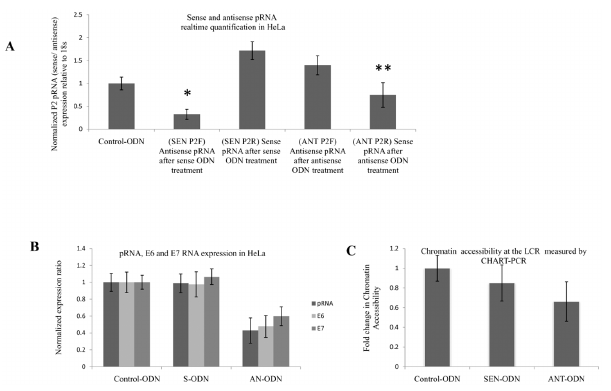
Fig 9. Requirement of pRNA transcription for gene expression. (A) Specificity of ODN targeting:ODNs were checked for modulating bidirectional transcription in HeLa. HeLa cells were treated with respective ODNs followed by analysis of pRNA expression using directional qRT-PCR with P2 primer. SEN P2F: HeLa cells transfected with sense ODN and P2 forward primer (antisense pRNA specific) used in directional RT-PCR SEN P2R: HeLa cells transfected with sense ODN and P2 reverse primer (sense pRNA specific) used in directional RT-PCR, ANT P2F: HeLa cells transfected with antisense ODN and P2 forward primer (antisense pRNA specific) used in directional RT-PCR, ANT P2R: HeLa cells transfected with sense ODN and P2 reverse primer (sense pRNA specific) used in directional RT-PCR Control-ODN: Control ODN treated cells. Expression ratio was calculated with respect to 18S rRNA by REST software normalized to Control dsRNA treated samples. (B) Effect of sense or antisense pRNA knockdown on pRNA, E6 and E7 expression by ODN in HeLa. Control-ODN: Control ODN transfected cells, SEN-ODN: sense ODN transfected cells, ANT-ODN: antisense ODN transfected cells. ( * ) P < 0.01, ( ** ) P < 0.05. C: Sense pRNA degradation mediated heterochromatization. Significant reduction in MNase digestion 72 hours after antisense ODN transfection while Control or sense ODN transfection had no effect in HeLa cells. Control-ODN: Control ODN transfected cells, SEN-ODN: cells transfected with sense ODN, ANT-ODN: cells transfected with antisense ODN, ( * ) P <